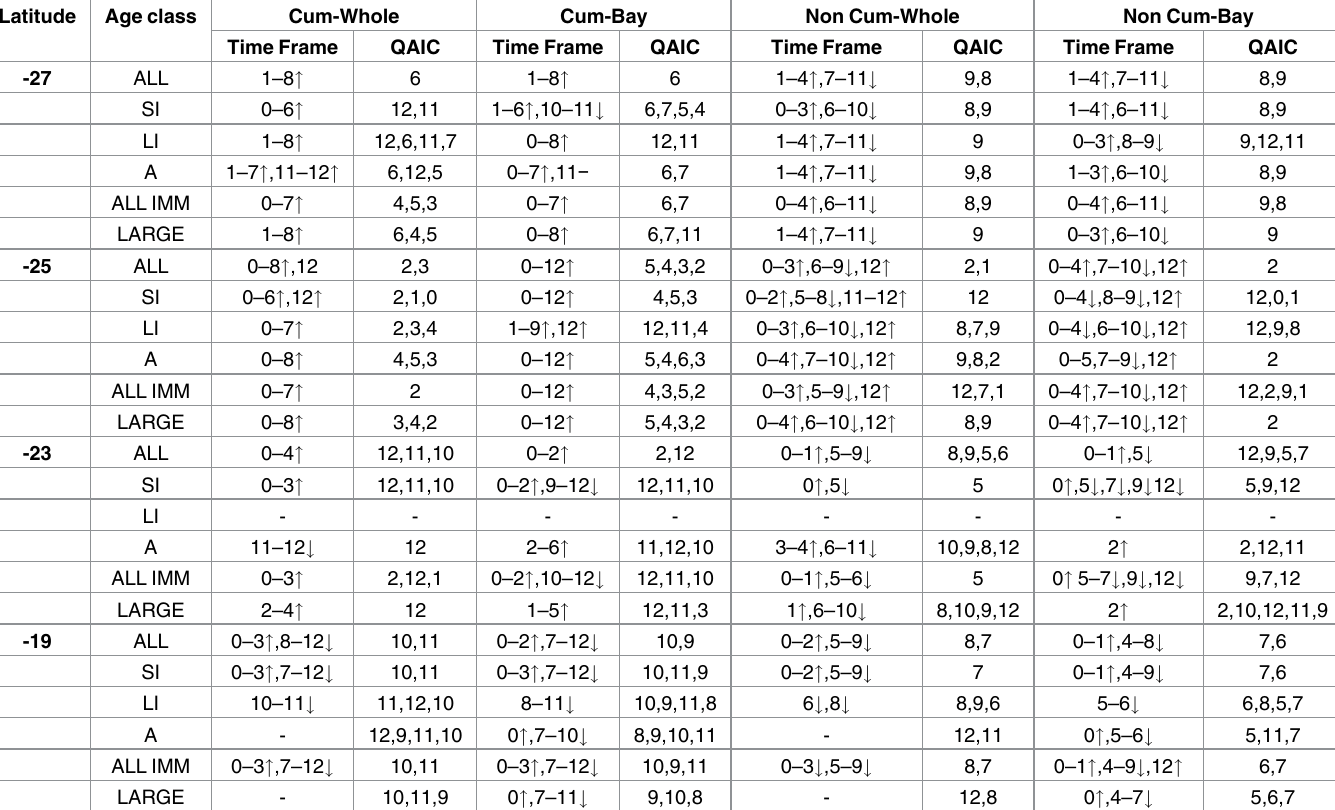
Table 15. Model results for all turtles and monthly averagedaily diurnal temperature difference. " denotes increasedstrandings rates with increased averagedaily diurnal temperature difference. # denotesdecreased strandingrates with increasedaveragedaily diurnaltemperaturedifference. Age class abbreviations: ALL = all turtles, SI = small immature, LI = large immatures, A = adult-sized, ALL IMM = all immature sized animals(small + large), Large = all large turtles (large immatures + adult-sized). The time frame is reportedin monthly rangeswhere responses were noted. The values reportedin qAIC are the months with the most significantqAIC